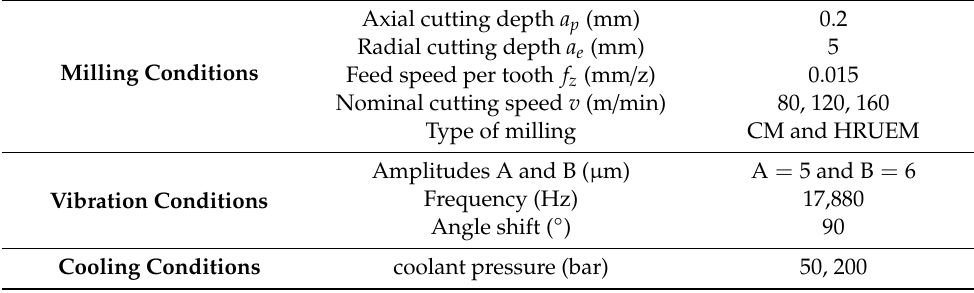
Table 3. Conditions of end milling experiments in CM and